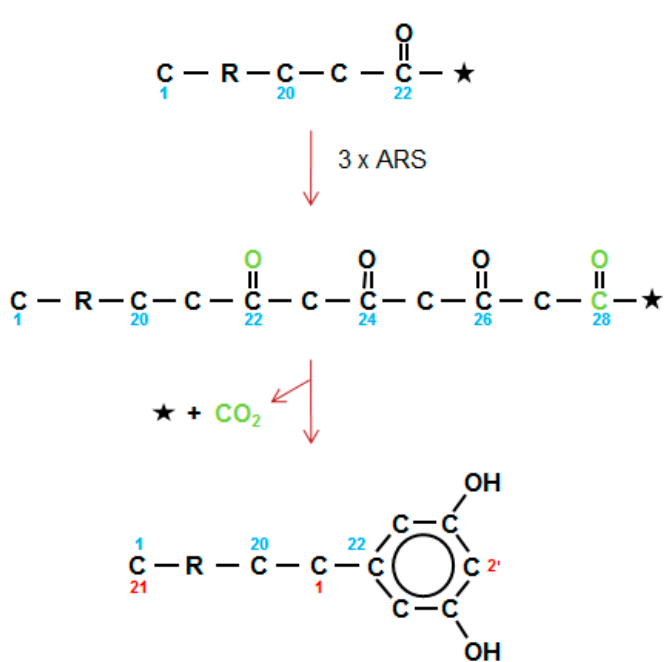
Figure 8. Type III alkylresorcinol synthases carry out three sequential elongations (3 × ARS) to give a theoretical tetraketide which then undergoes an aldol condensation, with the release of CoA (*) and CO 2 (green) forming the 1,3-dihydroxybenzene ring. The 28 carbon tetraketide gives an AR with an alkyl chain of 21. Alkyl side chains range for 13–27 carbons. Numbering in direction of synthesis shown in blue, and as required for IUPAC nomenclature in red.